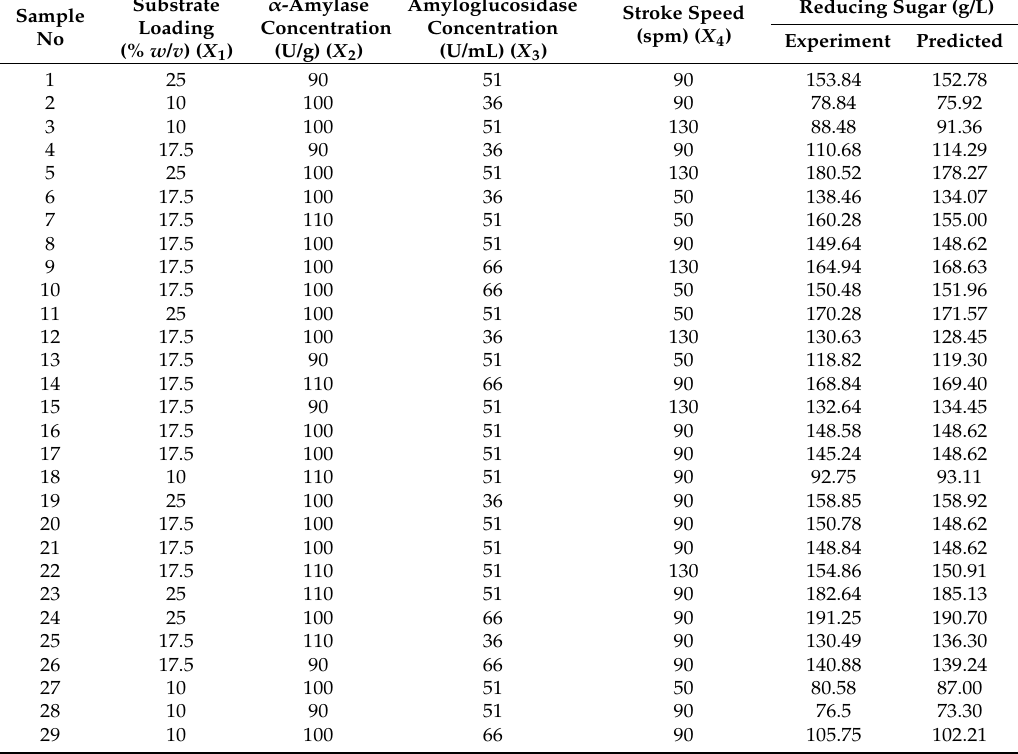
Table 5. Box-Behnken experimental design for the starch hydrolysis